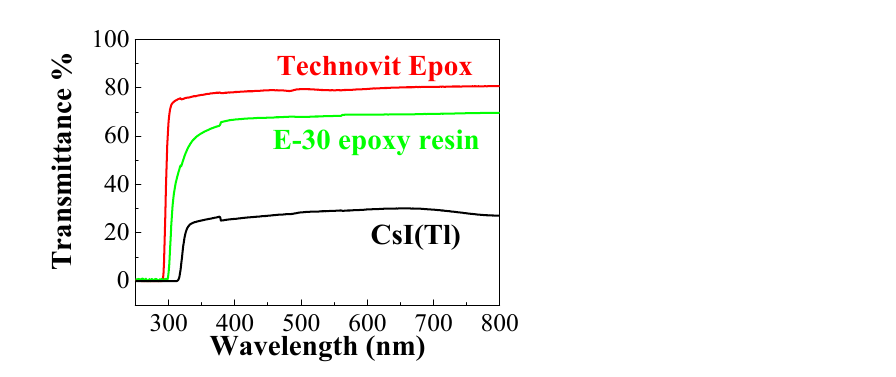
Figure 3. Transmittance spectra of the cured E-30 and Technovit Epox resins, and CsI(Tl) crystal. Spray technology was used to deposit the Technovit Epox resin on the CsI(Tl) crystal surface. As shown in Figure 4a, a continuous and defect-free coating layer of 0.5 mm thickness was deposited, leading to a coated crystal with a size of 35 mm. Such a type of coating can only slightly attenuate the fluorescent green light emitted by the scintillator crystal under UV radiation (see Figure 4b). According to the difficult peel-out of the Technovit Epox coating, a mechanically robust epoxy–crystal interface resulted. This very good ad- the epoxy–CsI(Tl) interface.